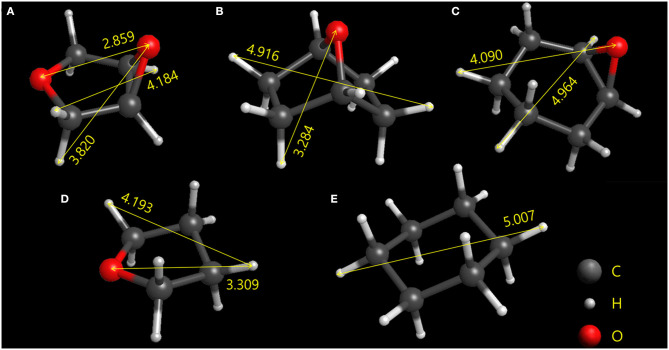
Optimized geometries of the (A) ETHF, (B) 14ECH, (C) 12ECH, (D) THF, and (E) CH. The longest center-to-center distances between each type of atom are given in angstroms.